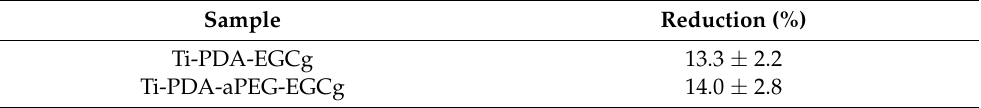
Table 2. Antioxidant power of Ti-PDA-EGCg, Ti-PDA-PEG-EGCg titanium cylinder, as measured by the DPPH